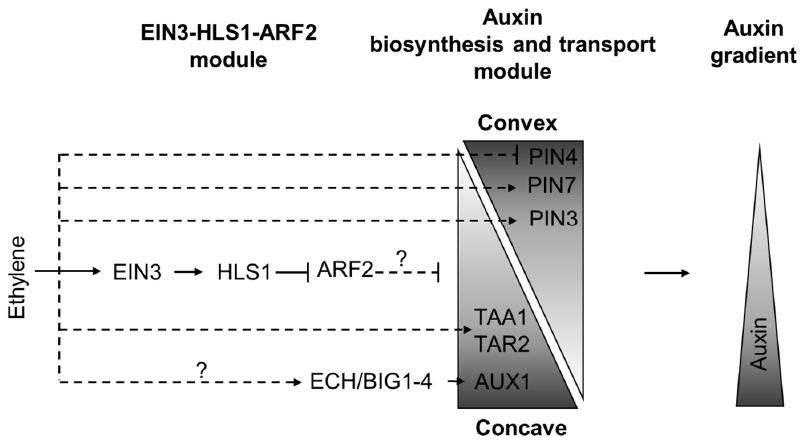
Figure 5. The model of ethylene influence on auxin distribution asymmetry during apical hook formation. In the hook (zone iv. in Figure 3), ethylene activates expression of HLS1 , which negatively regulates ARF2 levels to mediate asymmetric auxin distribution. Ethylene treatment downregulates PIN4, upregulates PIN3 and PIN7 expression in the epidermal cells of the hook. Simultaneously TAR2 and AUX1 expression is induced on the concave side of the apical hook. As a result, ethylene fine-tunes auxin maximum formation on the concave side of the hook. Dashed lines mark the regulatory events with unknown mechanisms, question marks highlight putative regulations. The triangles conditionally depict spatial molecular gradients. This model is based on findings reported previously